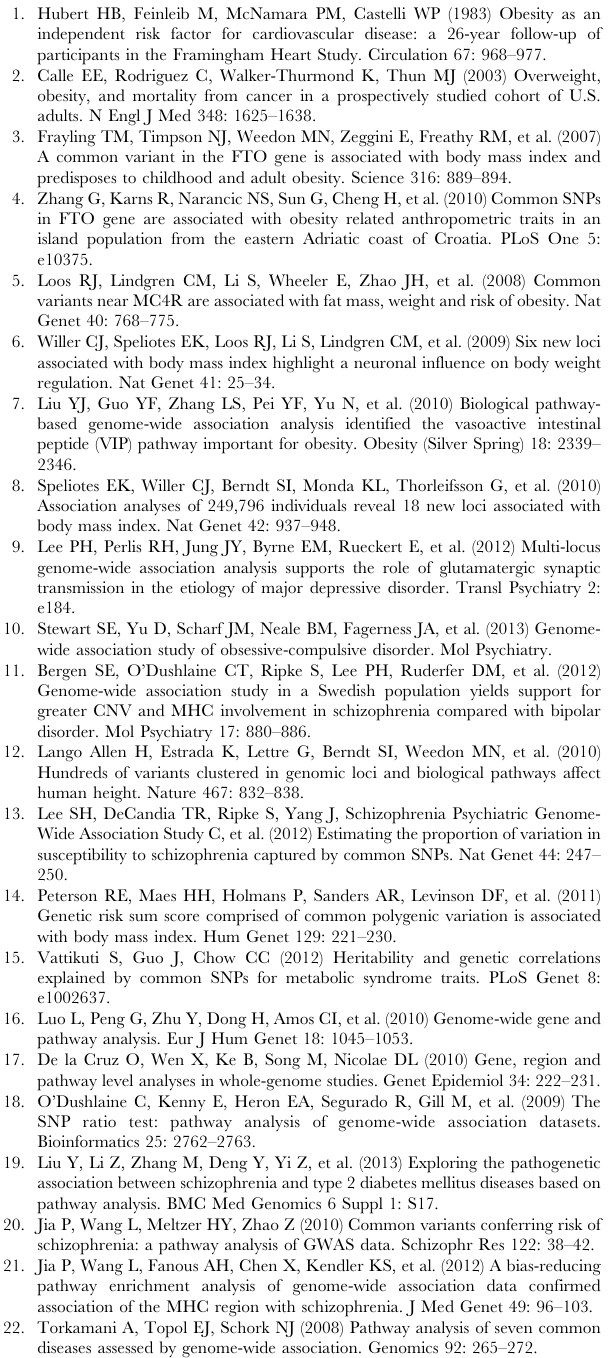
Table S11 Replication set population